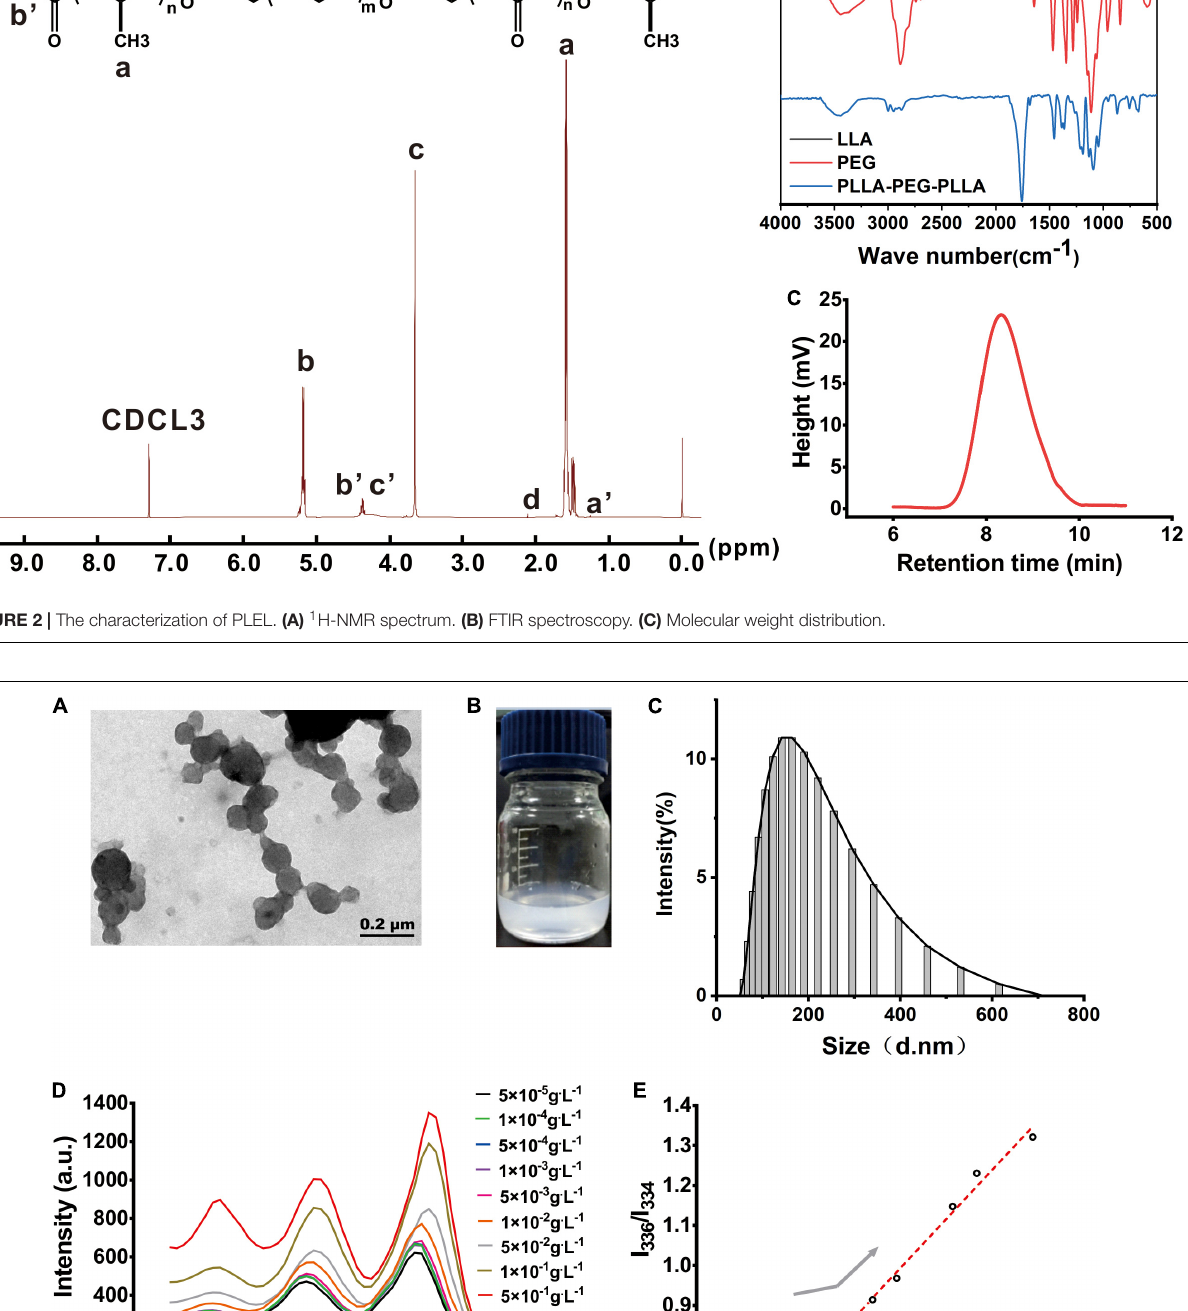
Frontiers in Bioengineering and Biotechnology |